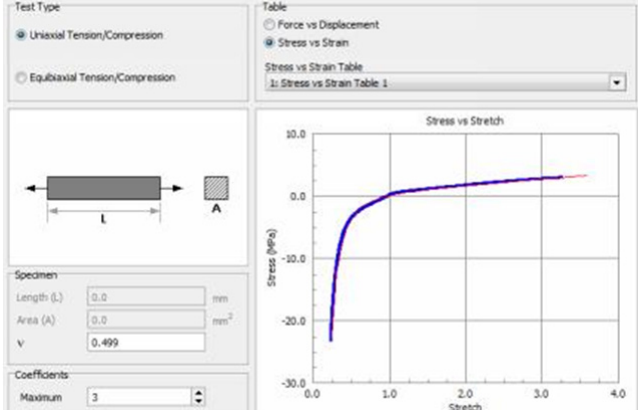
Fig. 11 Curve Fitting to establish Mooney-Rivlin Material Properties